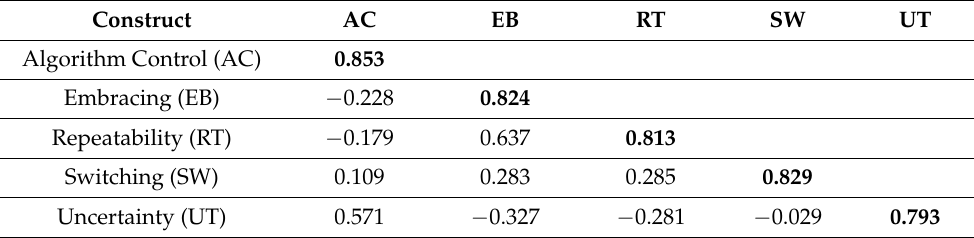
Table A3. Squared Pairwise Correlations and Assessment of the Discriminant Validity.